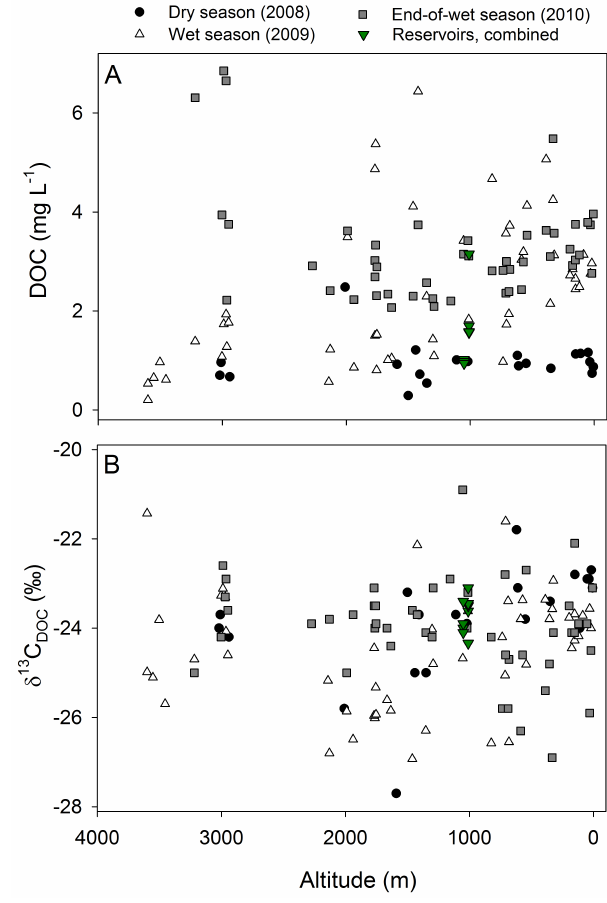
Fig. 4. Altitudinal profile of (A) δ 13 C POC and (B) POC:Chl a ra- tios along Tana River Basin during three sampling seasons. Data from the reservoirs are from all sampling campaigns combined and include those from Bouillon et al. (2009).